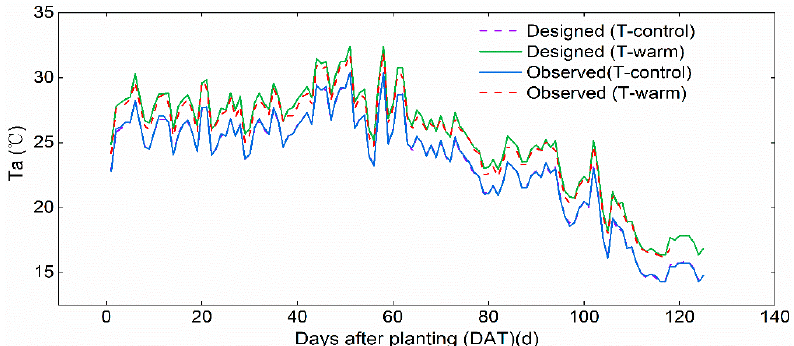
Figure 2. Daily variations of designed and actual Ta in maize growing seasons under T-control and T-warm scenarios.